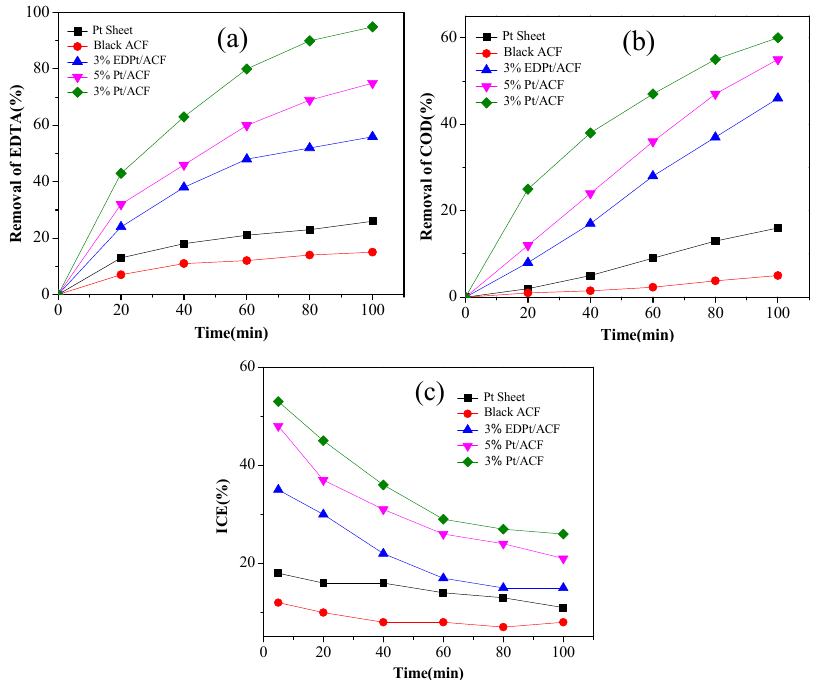
Figure 2. The effect of different electrodes on EDTA removal ( a ) concentration; ( b ) COD; ( c ) ICE (initial pH 5; initial EDTA concentration 300 mg/L; current density 40 mA/cm 2 ; electrolyte concentration 0.1 mol/L). EDTA: ethylenediaminetetra ‐ acetic acid.